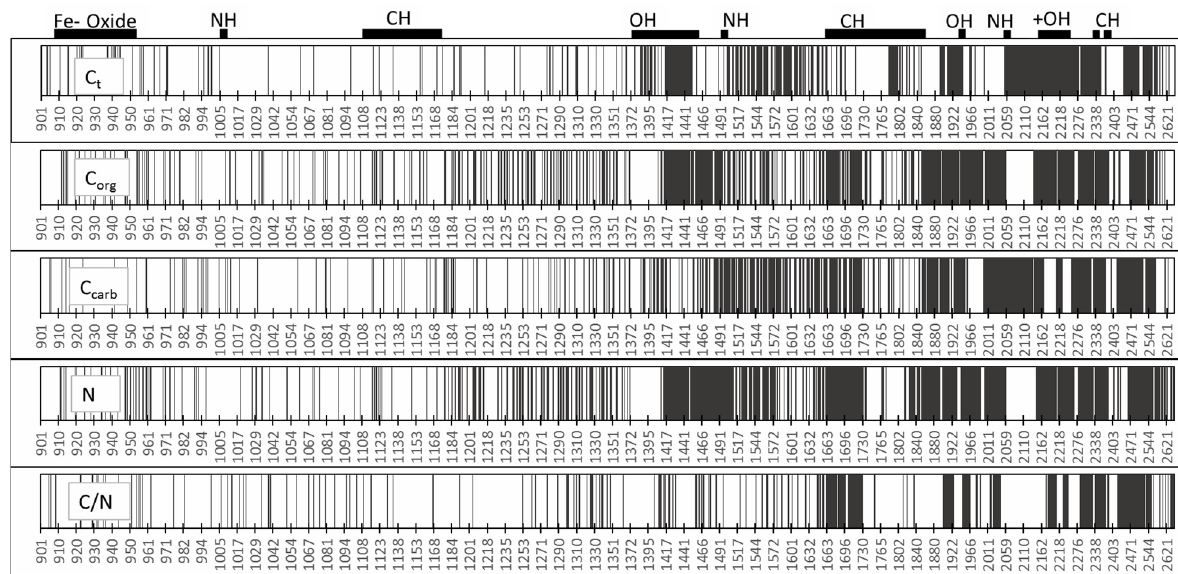
Figure 7. Important wavelengths for the prediction of Ct, Corg, Ccarb, and C/N. Specific reflection wavebands for the different areas for soil are specified on the top (modified from [74]).